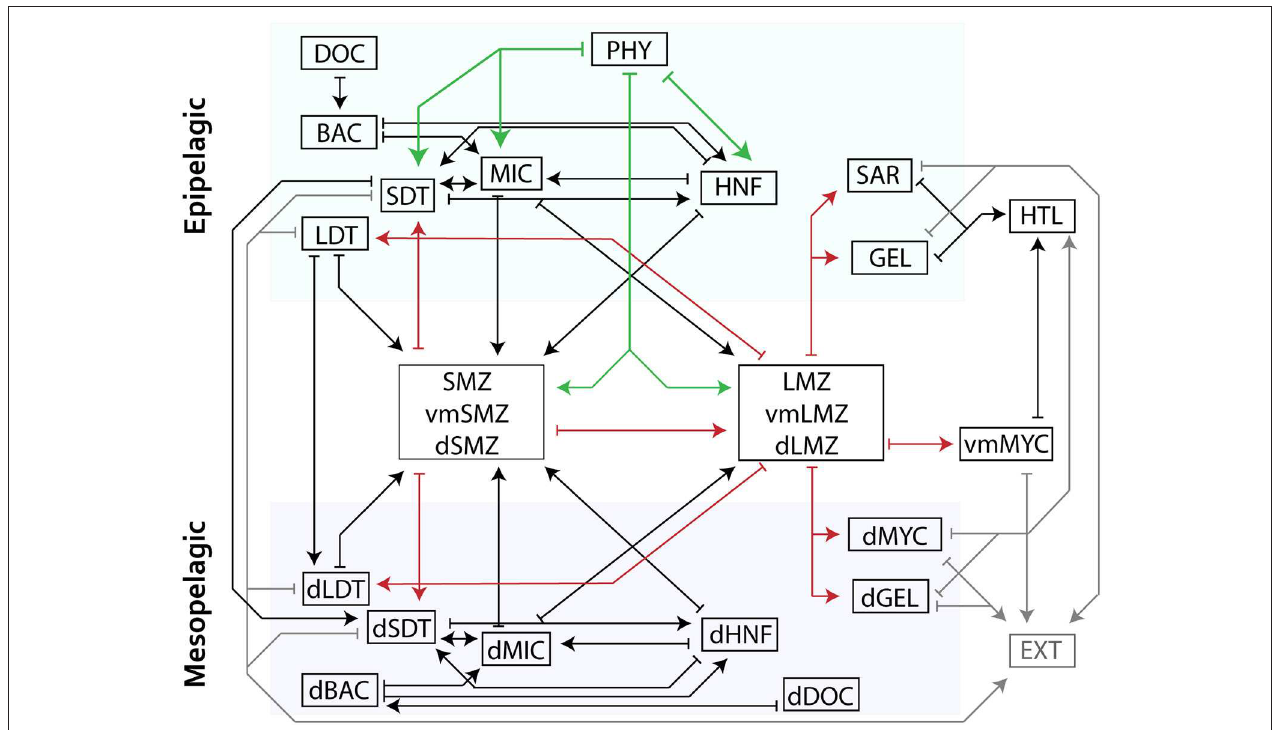
FIGURE 1 | Schematic of model structure organized into distinct layers (epipelagic, DVM, and mesopelagic) where arrows indicate a model flow. Mesozooplankton compartments are shown in aggregated boxes (i.e., small mesozooplankton consisting of SMZ, vmSMZ, and dSMZ are shown together). For clarity, green arrows indicate grazing while red highlight mesozooplankton flows. Closure terms (“EXT”) are in gray. Production of DOC is not shown but would flow from each living compartment to DOC/dDOC. Losses to respiration are also not shown. See Table 2 for abbreviations.